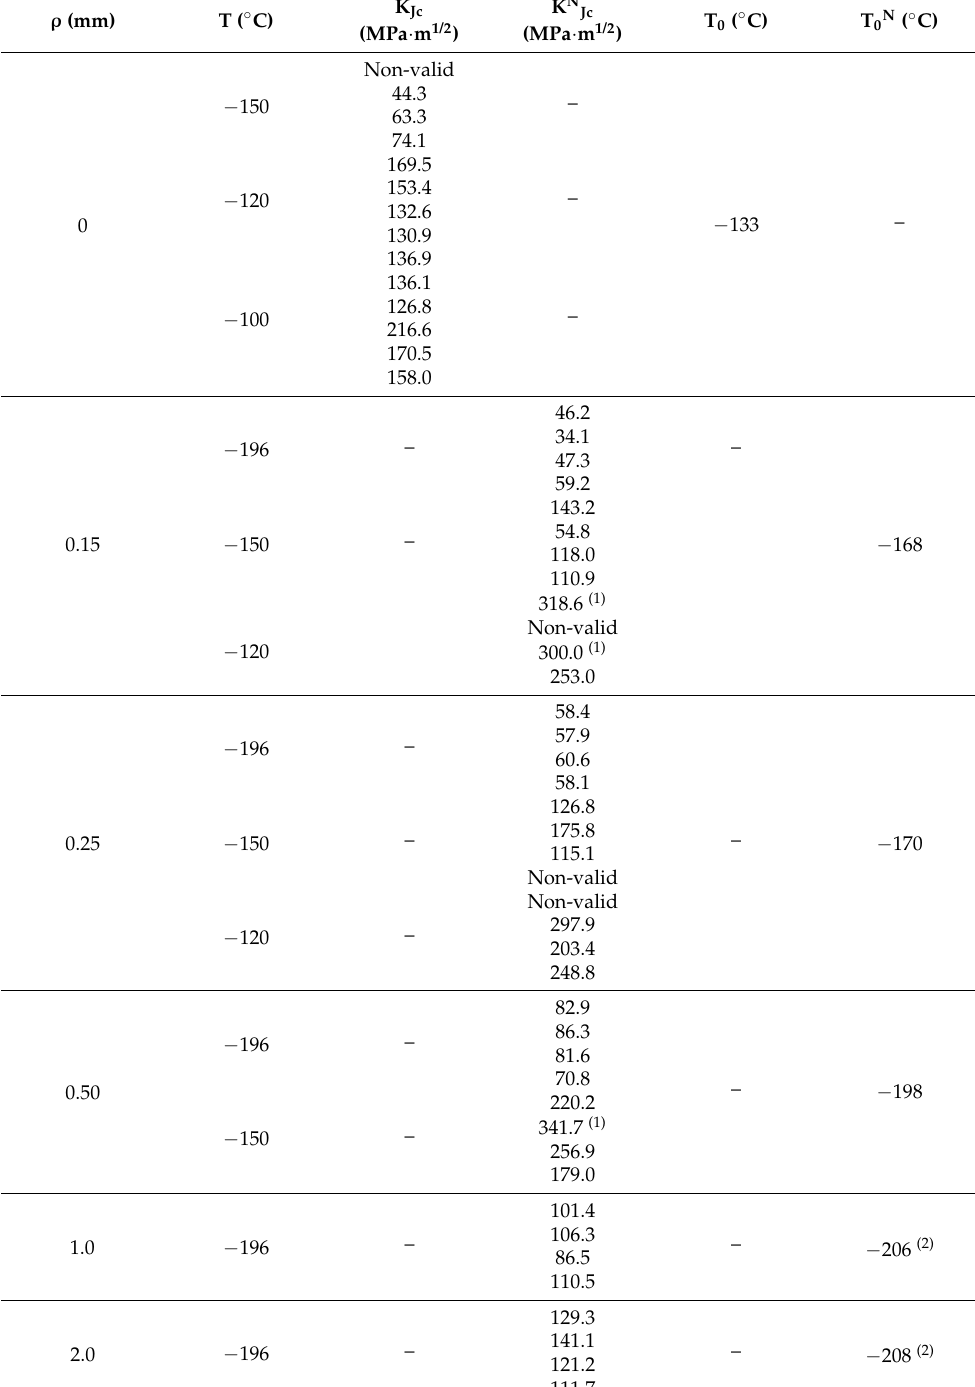
Table A2. Fracture toughness (K Jc ) and apparent fracture toughness (K N Jc ) results in steel S355J2, together with reference temperature results. 1T (25 mm thick) CT